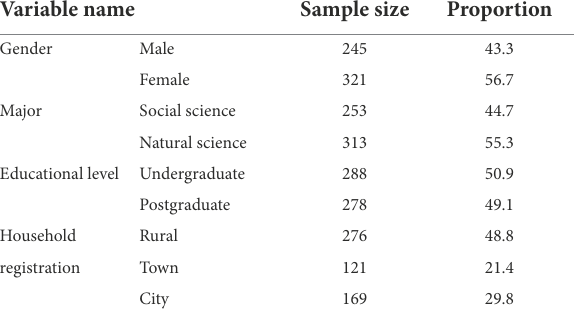
TABLE 1 Basic characteristics of samples ( N =